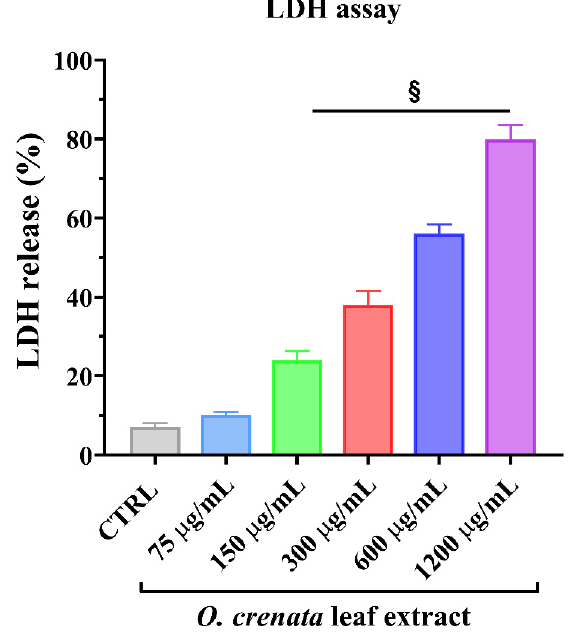
Figure 3. Lactic dehydrogenase (LDH) is released from MCF-7 cells at the steady state (control, CTRL) and after 24 h of treatment with increasing concentrations (from 75 to 1200 µg/mL) of OCLE. Values are the mean ± SD of four experiments in triplicate. § p < 0.0001 vs. untreated control.